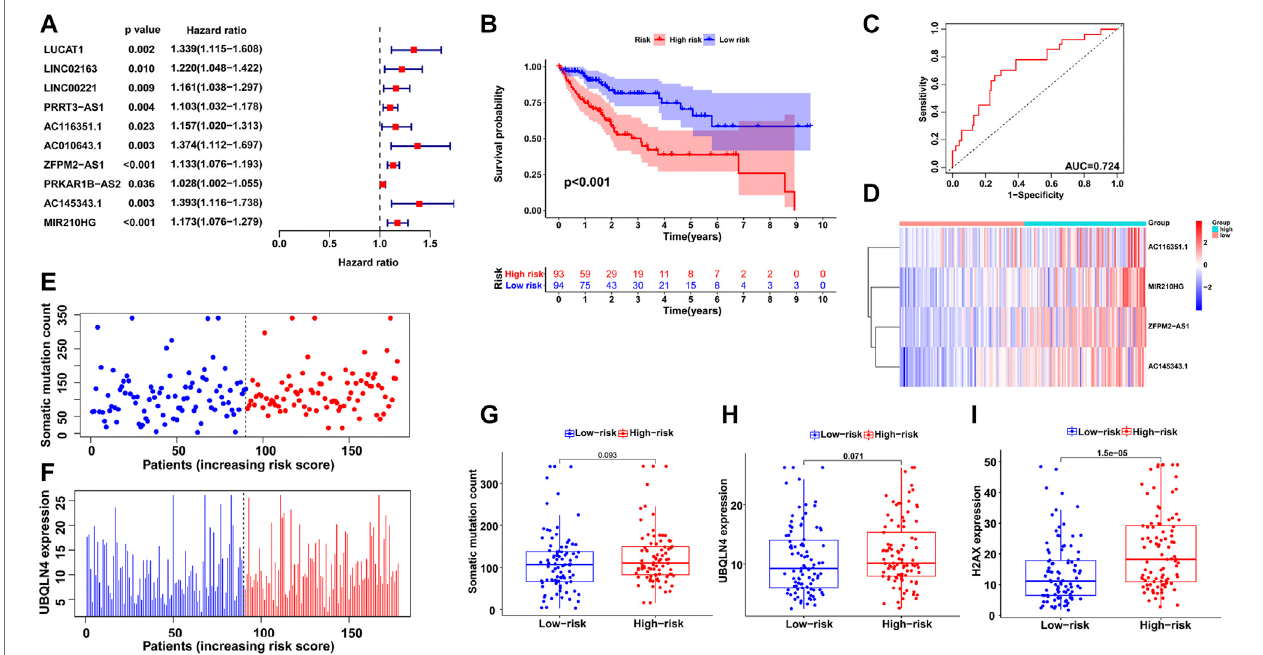
FIGURE 3 | Establishment of GILncSig for prognosis prediction in the training group. (A) Univariate Cox regression analysis of the GI-related lncRNAs associated with overall survival in the training group. (B) Kaplan – Meier survival analysis of high-risk and low-risk groups predicted by the GILncSig. (C) ROC curve to evaluate the performance of the GILncSig. (D) The expression pattern of the GILncSig in the training group. (E) Distribution of somatic mutations with increasing risk score. (F) UBQLN4 expression with increasing risk score. The boxplots of the distribution of somatic mutations, (G) UBQLN4 expression (H) and H2AX expression (I) between the high-risk and low-risk groups in the training group.